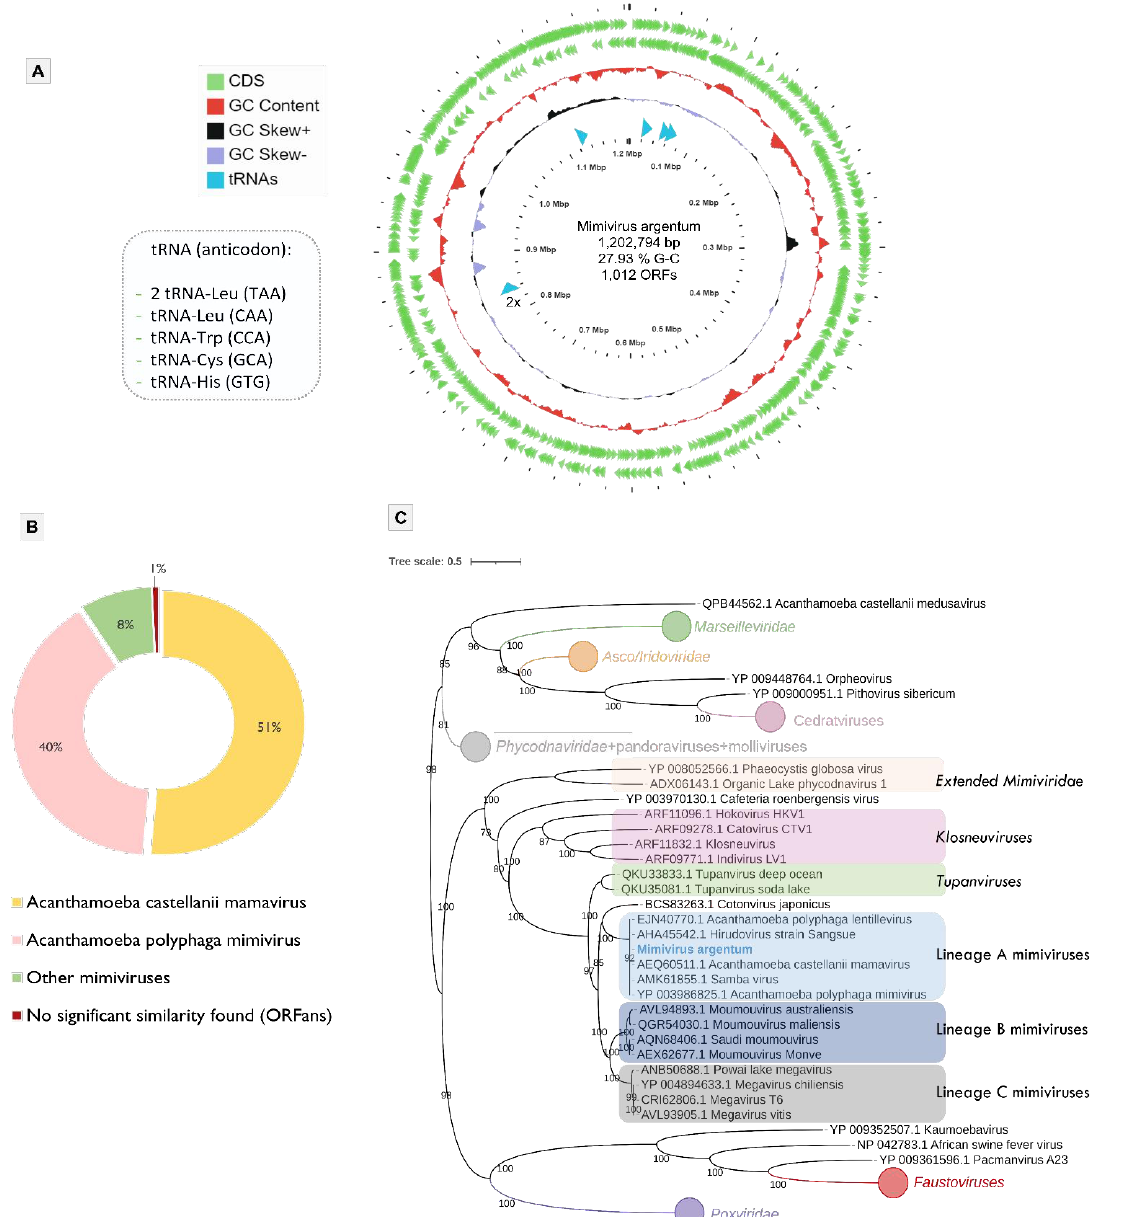
Figure 2. Genomic and phylogenetic features of mimivirus argentum. ( A ) Representative map of the mimivirus argentum genome. In the distribution of ORFs and tRNAs throughout the sequence, the G-C content and G-C skew are represented by different ring colors, as indicated in the color legend. The outer green ring represents the positive sense strand, whereas the inner green ring represents the negative sense strand. The box in the left specifies the six tRNAs coded by mimivirus argentum. The tRNA blue arrow indicated with “2 × ” shows two tRNAs closely located in genome. ( B ) Characterization of BLASTp best hits obtained during mimivirus argentum genome annotation. ( C ) Maximum-likelihood phylogenetic tree of nucleocytoviricota based on the DNA polymerase B amino acids sequences (ORF678 coded by mimivirus argentum). The results observed in this tree can be reinforced by other phylogenetic trees based on nucleocytoviricota conserved proteins, which are shown in the supplementary material (Figure S1A–C). The mimivirus argentum sequence is labeled with blue and bold font. The best-fit model chosen with ModelFinder (implemented in IQtree) for this tree was VT + F + R5. The tree scale bar represents the number of amino acid substitutions per site. CDS, coding sequences; tRNA, transfer